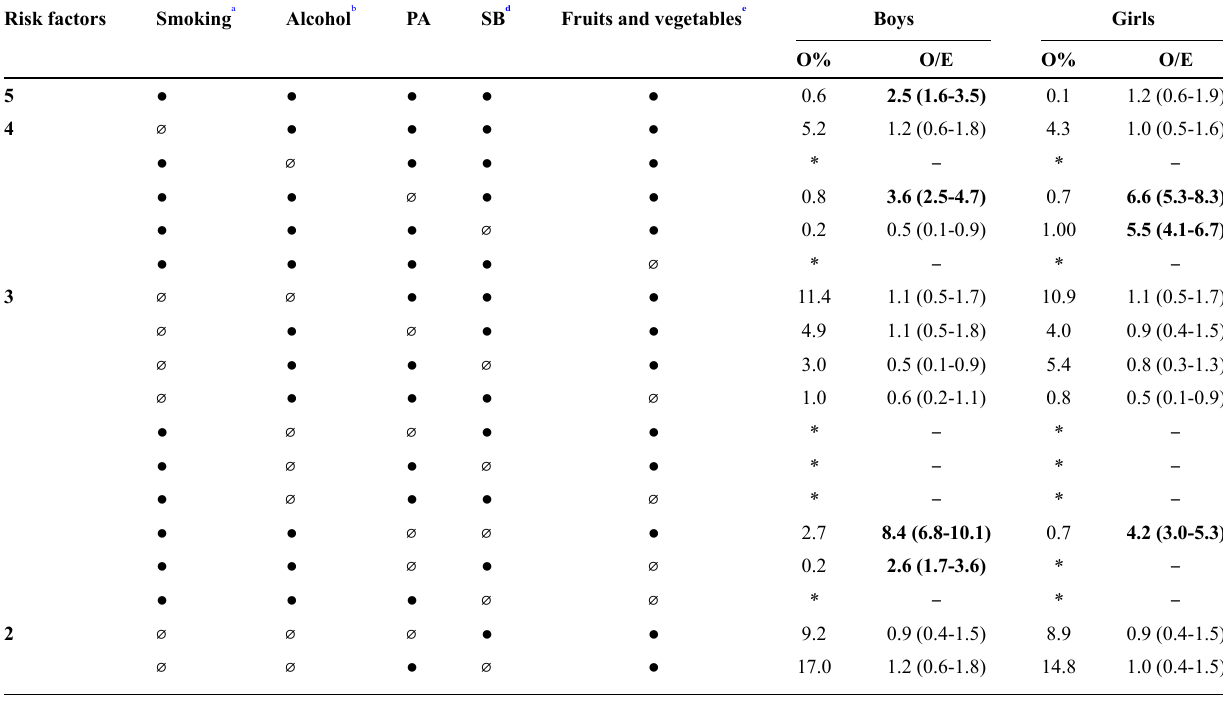
Table 2 - Clustering of modifiable risk factors for CVD stratified by sex. ACtVU Study. Uberaba, Brazil (2015). Risk